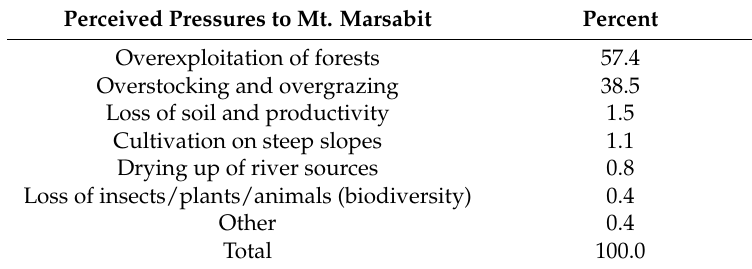
Table 2. Perceived pressures and impacts to Mt. Marsabit forest ecosystem ( n =